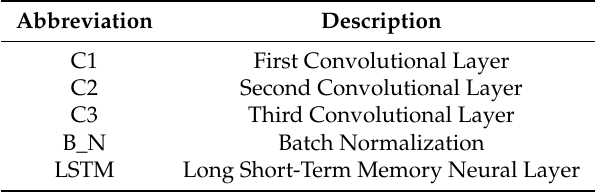
Table 3. Abbreviations for different methods utilized.